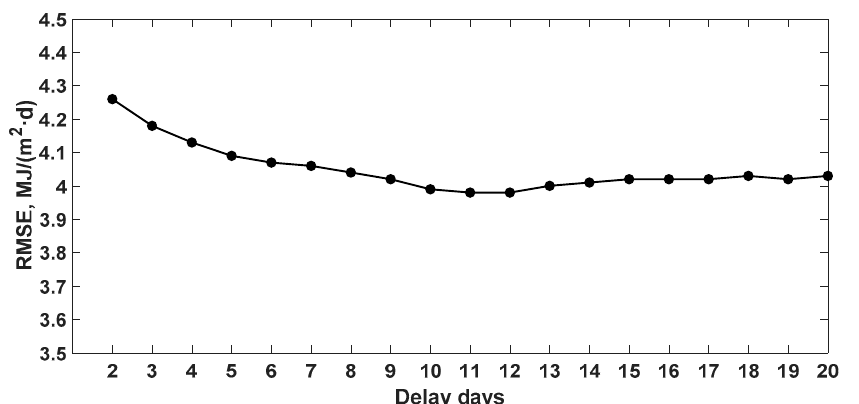
Figure 8. Effectiveness of prediction of the horizontal daily global solar irradiation the day after, simulated with the weighted moving mean model, together with the variable measured values in 2011, as a function of the considered number of delay (from 2 to 20 days). RMSE, root mean square error (MJ/(m 2 ·d)).